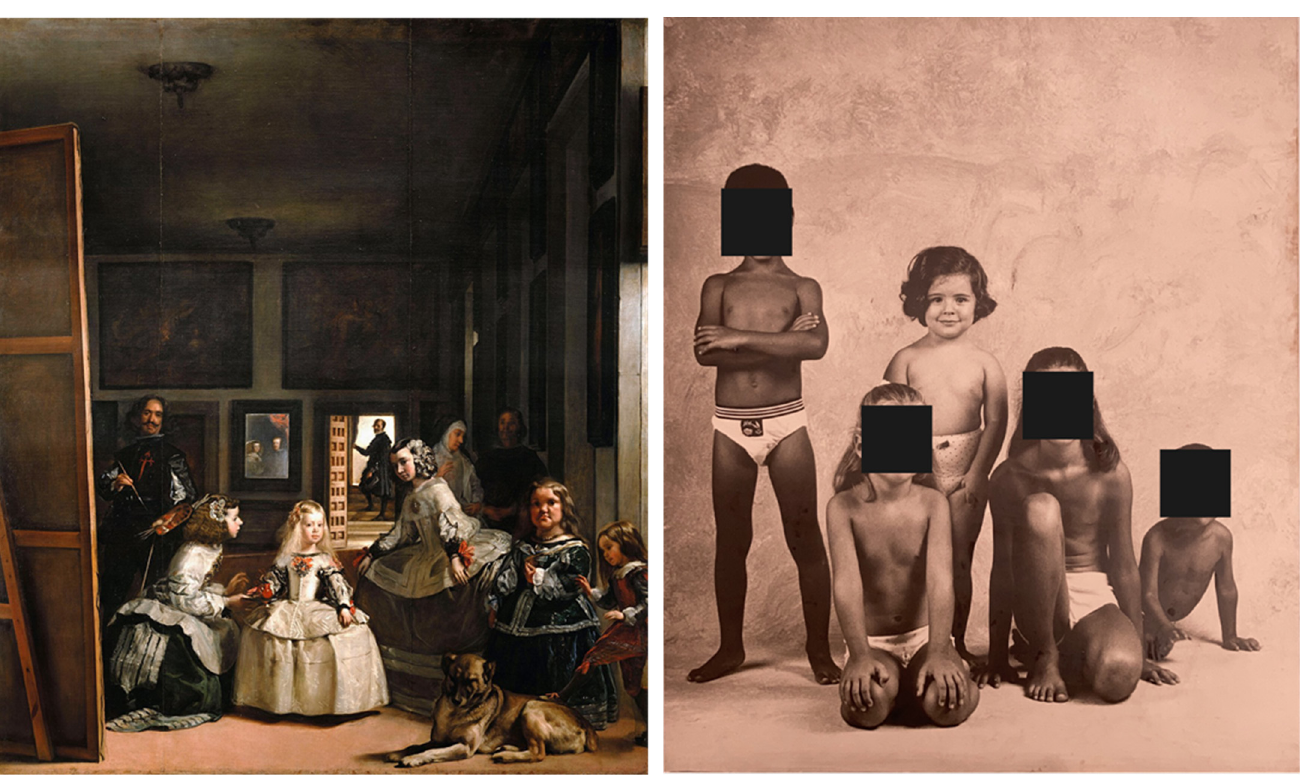
Figure 3. ( Left ) Diego Velázquez. 1656. Las Meninas . ( Right ) Author’s own picture of ad campaign for the author’s family’s clothing store, c. 1989. Photo modified by